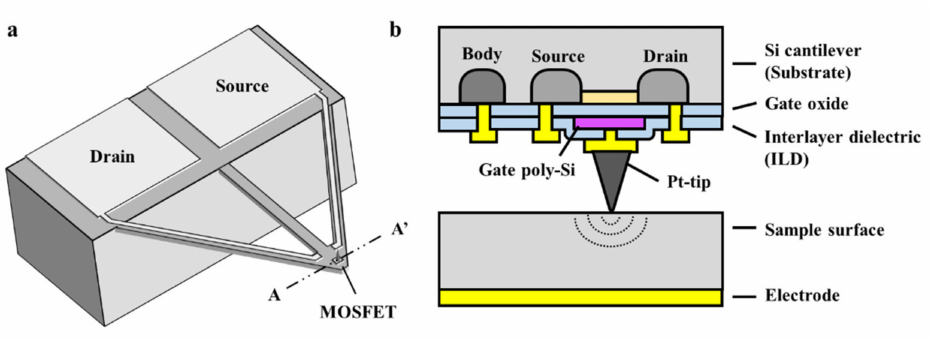
Figure 1. Schematic of the tip-on-gate of field-effect-transistor (ToGoFET) probe: ( a ) overall structure, and ( b ) cross-section of the sensing region. The inbuilt metal-oxide-semiconductor field-effect- transistor (MOSFET) is embedded at the end of the cantilever as a sensing component. The structure is identical to the typical planar MOSFET, and each electrode is connected to the pad along the V-shaped